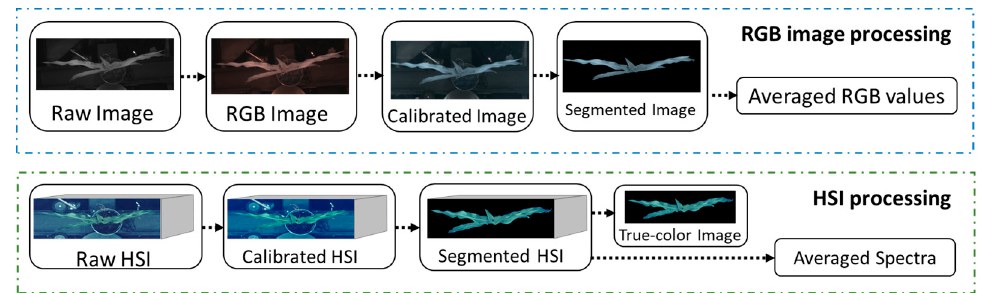
Figure 3. Flowchart of image processing. HSI, hyperspectral image.